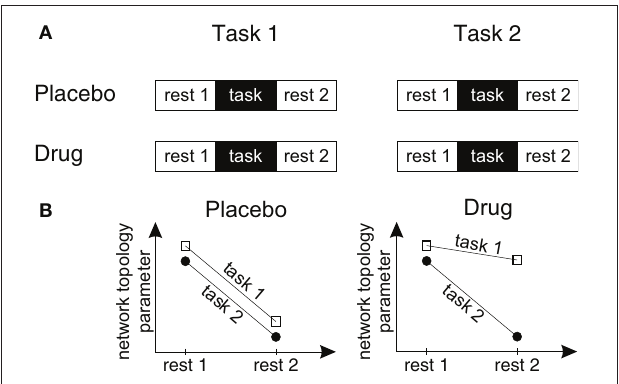
FIGURE 2 | A study design to measure drug effects on brain network topology in fMRI studies. (A) To measure the effects of drugs, tasks and drug-by-task interactions on endogenous brain network topology we suggest a design with four different fMRI scans. Within each fMRI scan participants are measured during rest periods before and following a task block in which participants perform one of two different task